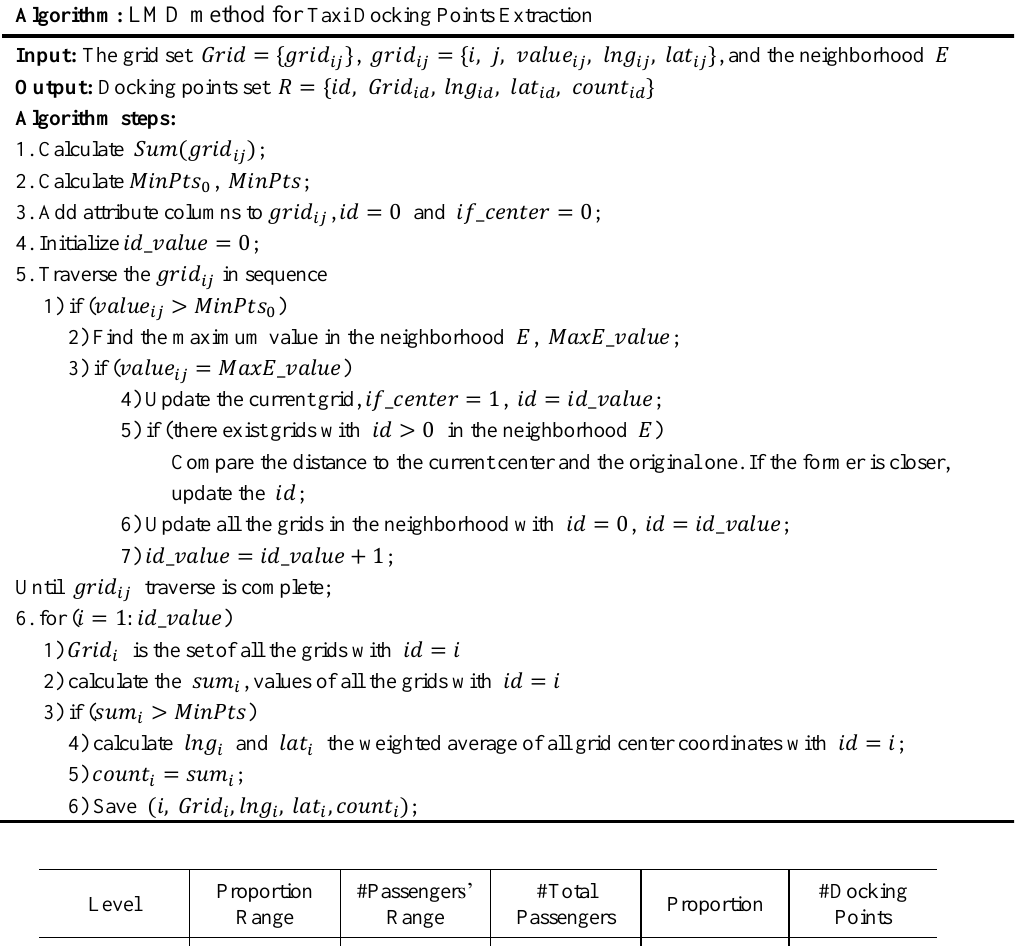
Algorithm: LMD method for Taxi Docking Points